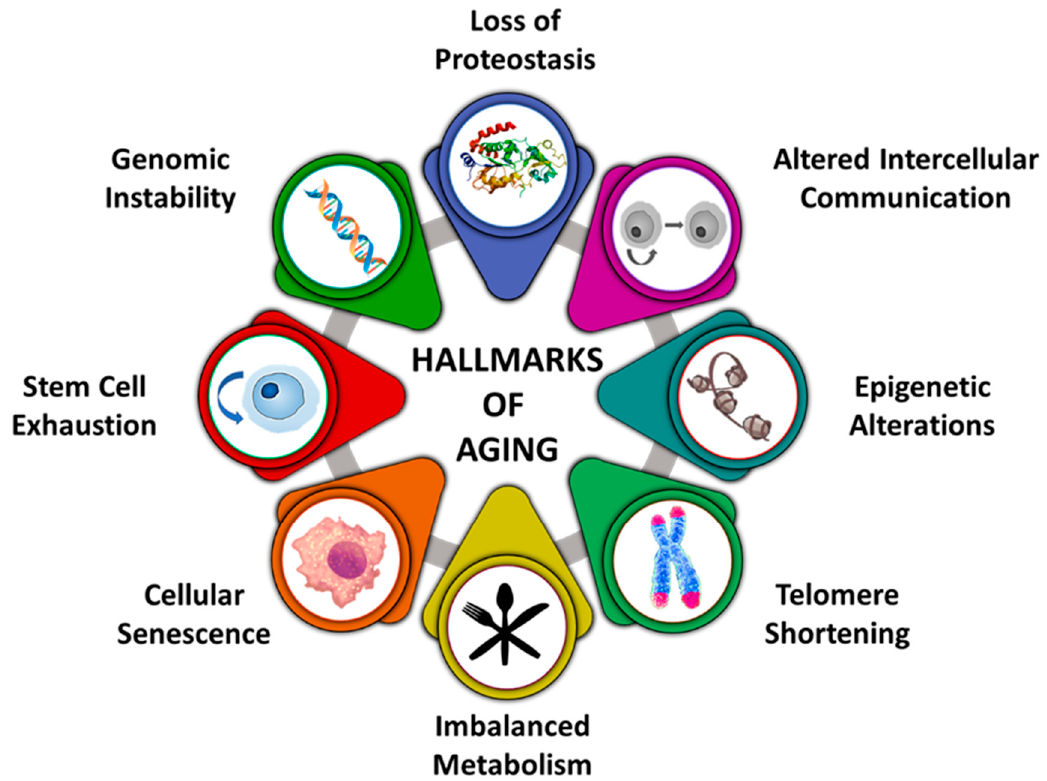
Figure 1. Hallmarks contributing to ageing.